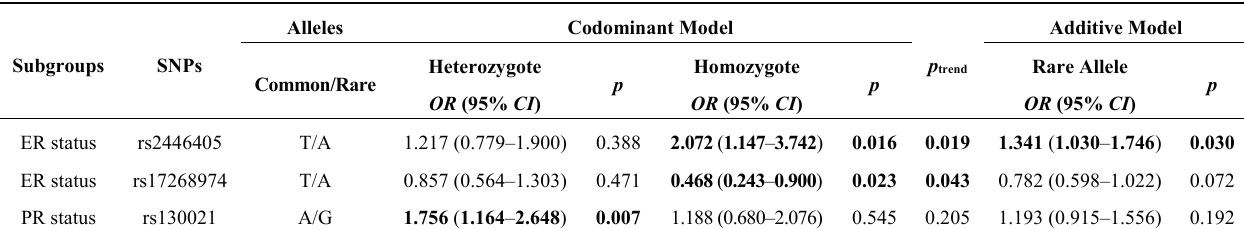
Table 7. Case-case comparisons for the associations of polymorphisms by subgroups of ER and PR